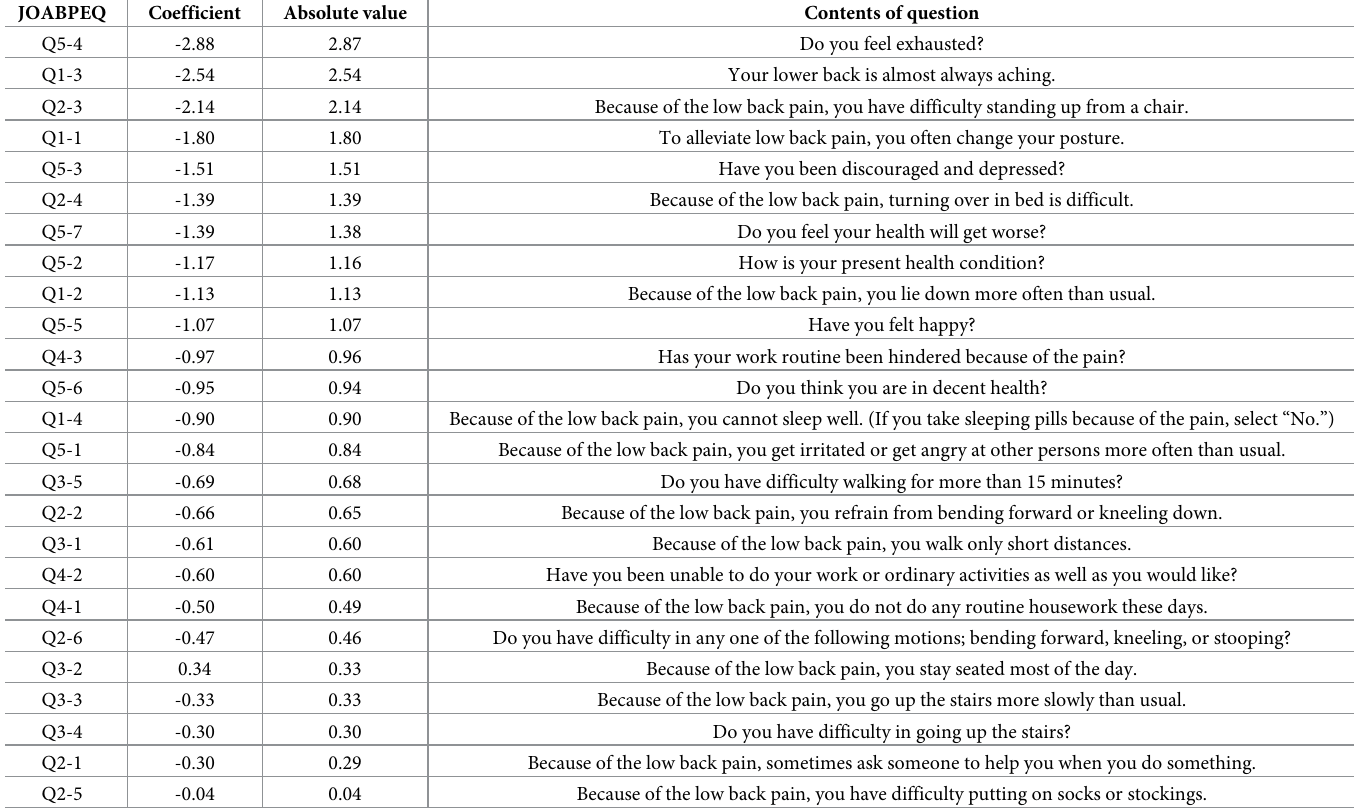
Table 2. Regression coefficients of each JOABPEQ item for the degree of lower back pain (in descending order of absolute value).